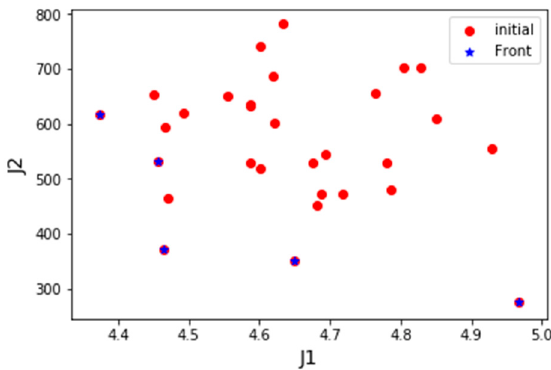
Figure 9. Initial “biological” performance index distribution of Scenario 1.